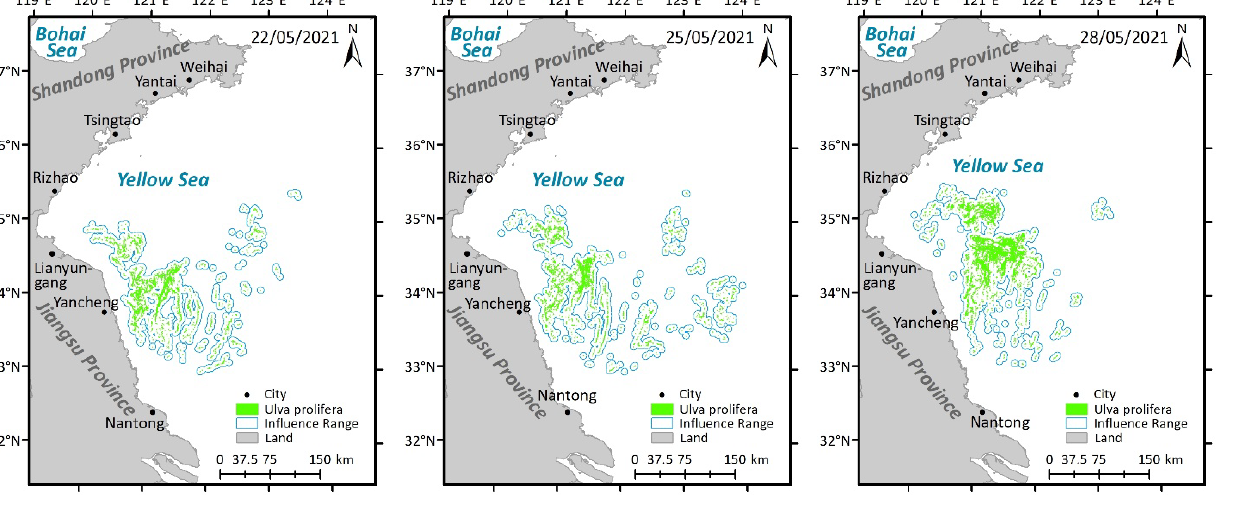
Figure 7 . Cont. Figure 7. Cont